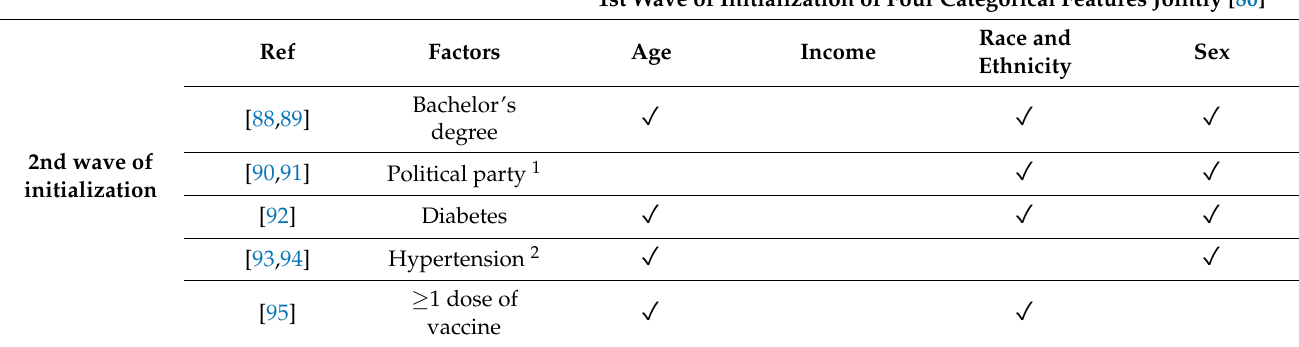
1 Two steps are involved: first we apply a population-wide probability of voting (agents who do not vote are ‘undecided’), then we subdivide agents into Democrats and Republicans based on sex, race and ethnicity. 2 Hypertension is created after agents have been assigned a level of diabetes, to ensure that diabetic agents have twice the risk for hypertension [93].